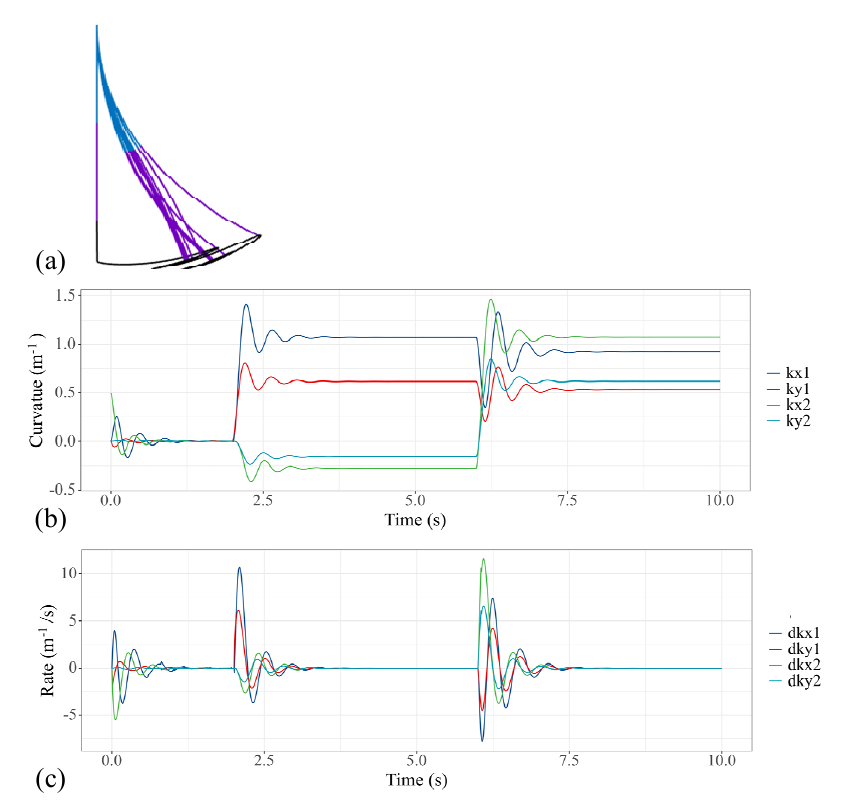
Figure 6. Simulation results of the soft manipulator when the first, fifth and sixth actuators are actuated by step torque. ( a ) Soft manipulator trajectory versus time. ( b ) Curves of the bending curvature versus time. ( c ) Curves of speed versus time.